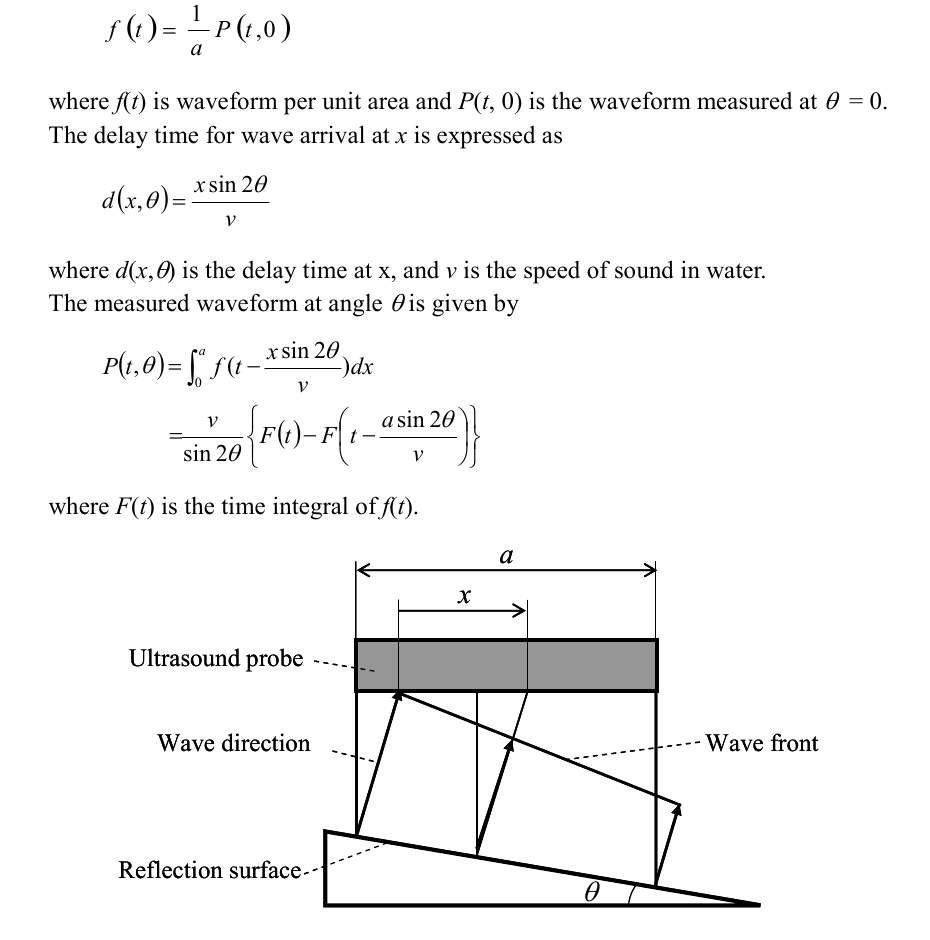
Figure 3: Two-dimensional model of a wave incident upon the ultrasound probe. a is the diameter of ultrasound probe, q is the angle of reflection surface and x is the distance from the first point at which ultrasound wave